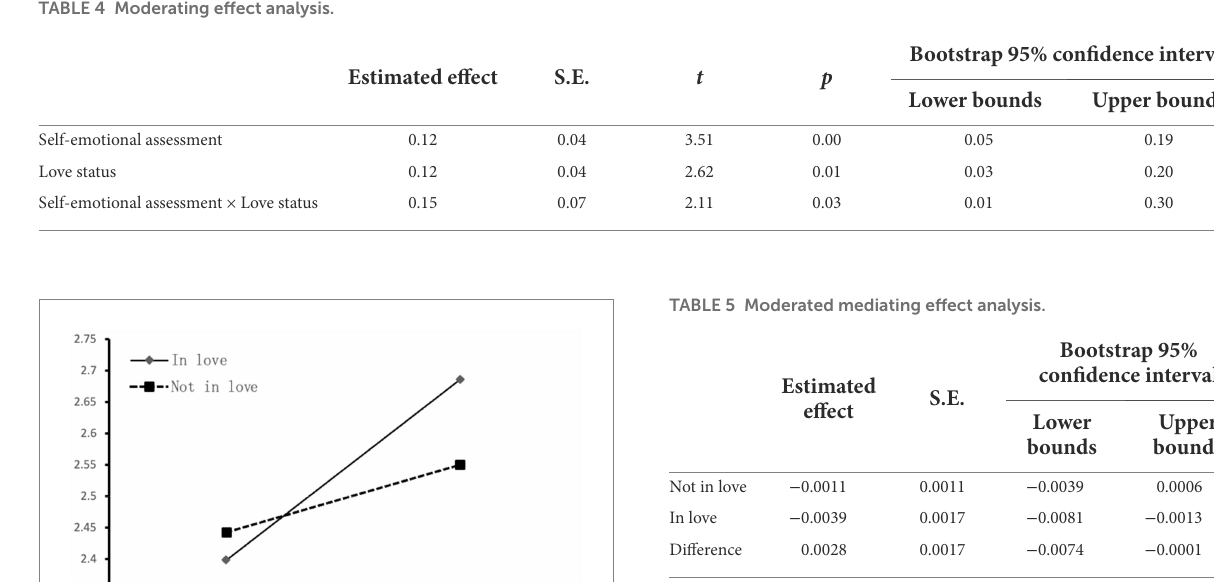
TABLE 4 Moderating effect analysis.